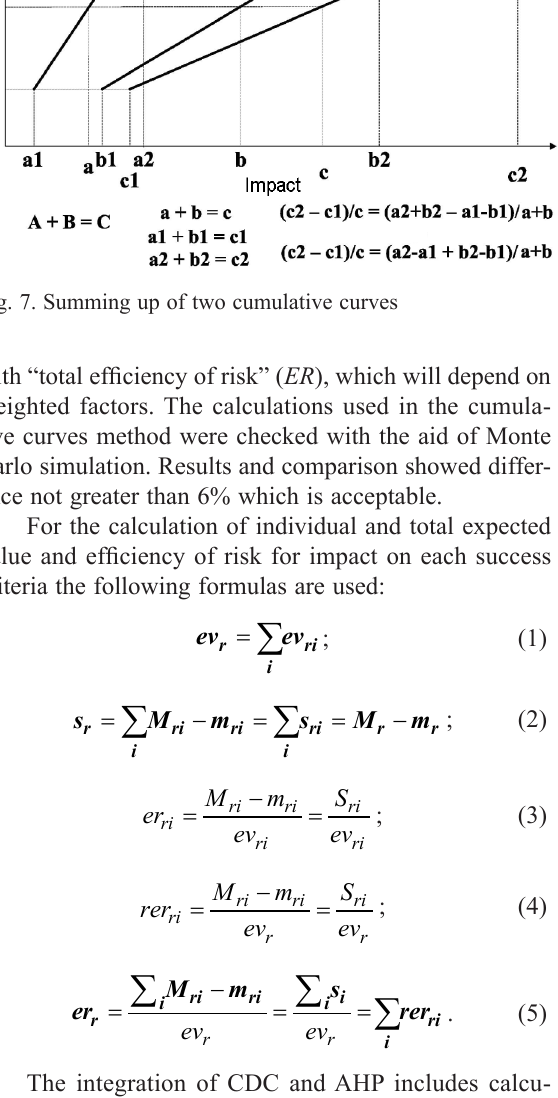
Fig. 5. Illustration of risk and uncertainty measures on ideal case of cumulative distribution curve (adopted from Chapman 2006)